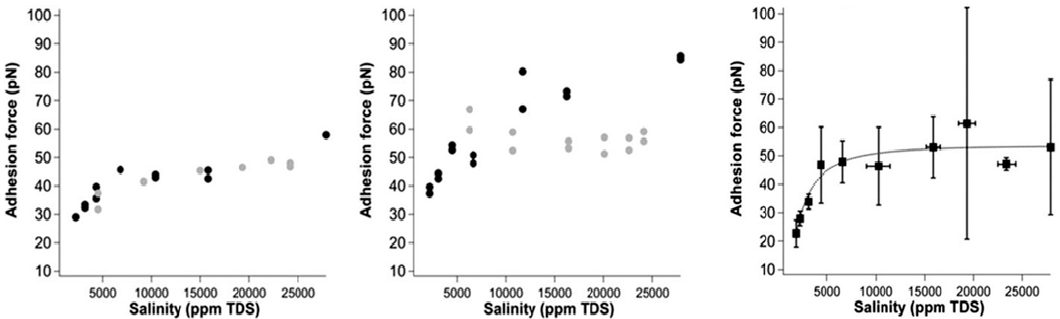
Figure 6. Adhesion force between the tip and the rock surface of data plotted as a function of salinity for Sample 1 ( left ), sample 2 ( middle ) and line of fit for all samples ( right ) (reproduced from Hilner et al. [54]).